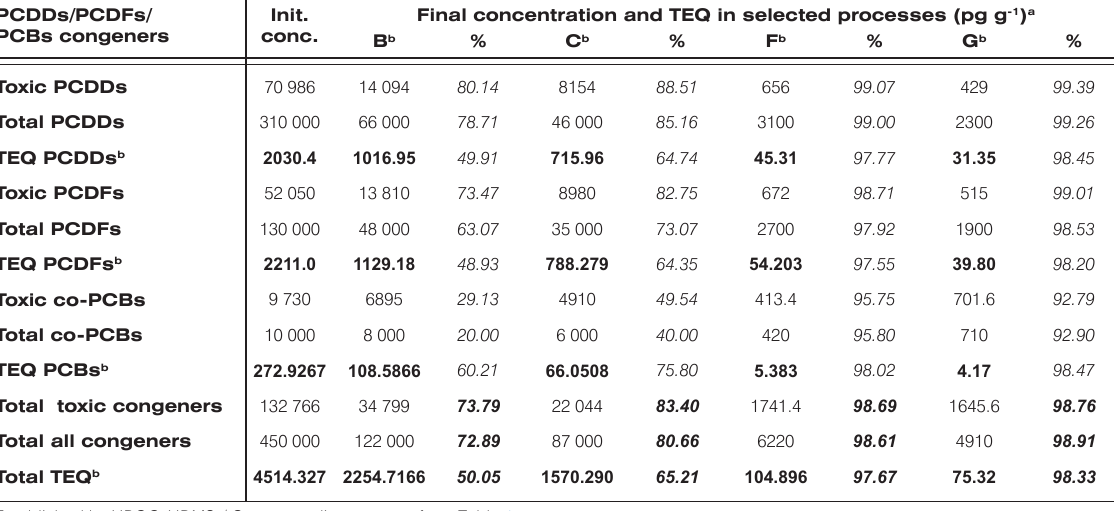
Table 5. Total concentrations, TEQs, and degradation yields. PCDDs/PCDFs/ PCBs congeners